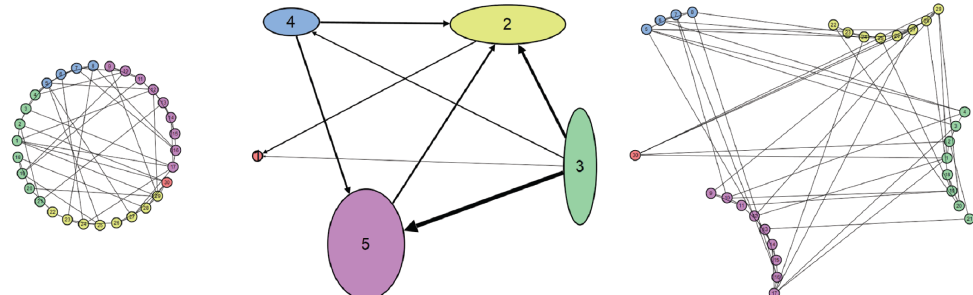
Figure 2: Graph G (with clusters marked by different colours), overview graph G respective colour) and mental-map preserving layout of G (preserving the structure of the overview graph within the graph G ), in this case also without re-layout of the different clustered sub-graphs (from left to